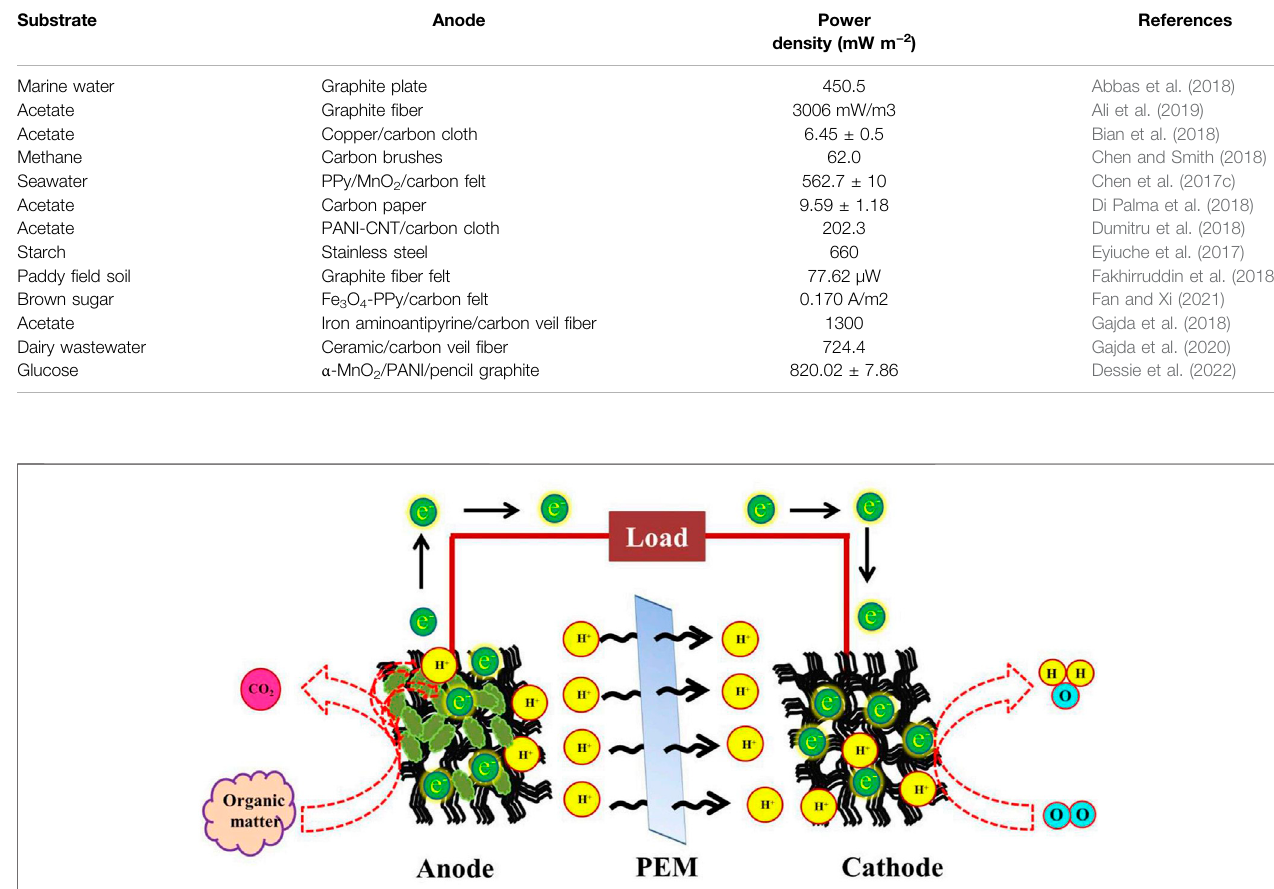
Frontiers in Nanotechnology |